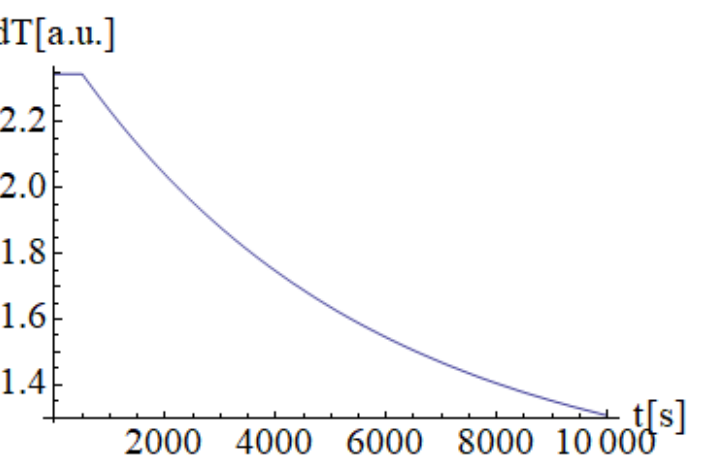
Figure 4. Results of the Non-Fourier heat equation.